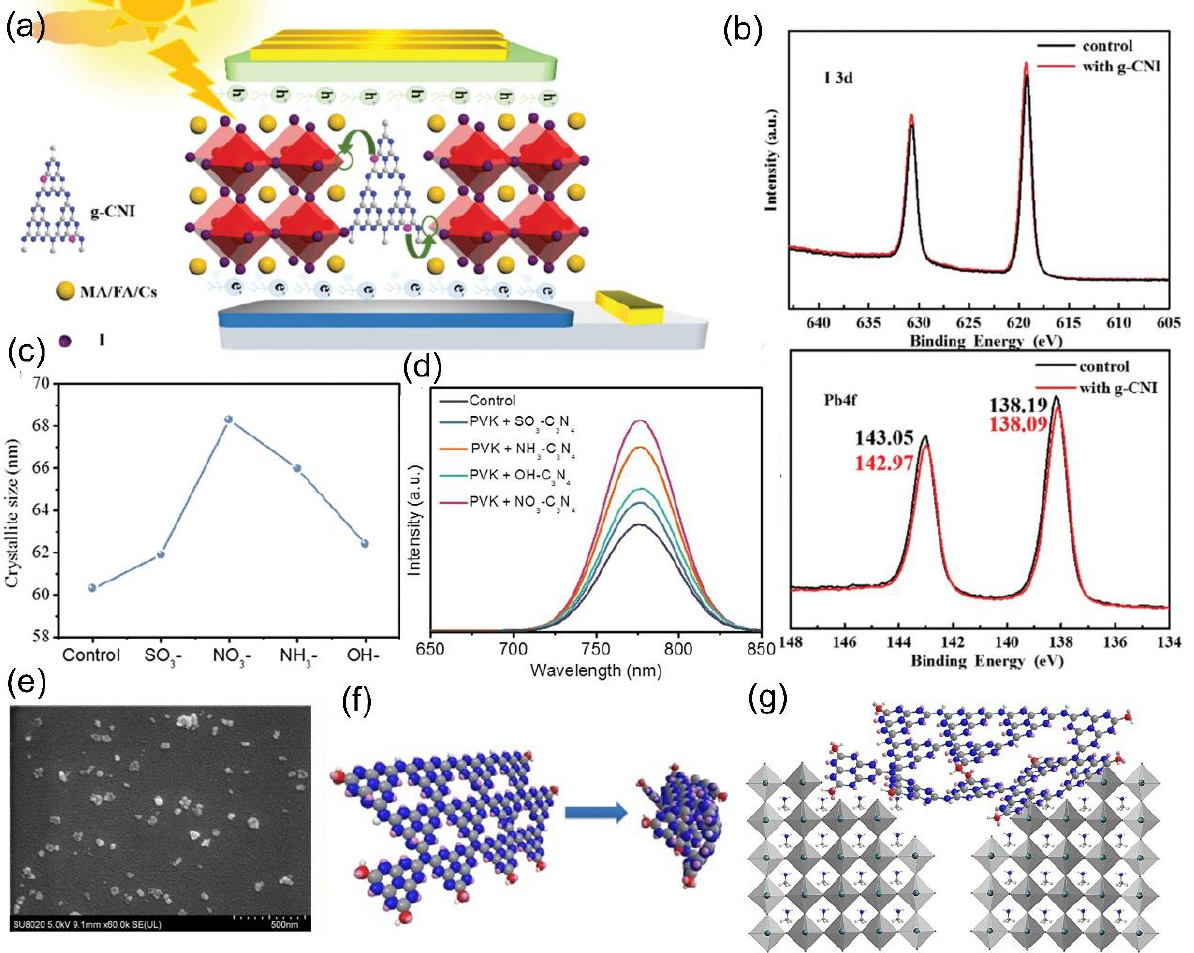
Figure 3. ( a ) Mechanism illustration of g – CNI modified PSCs. ( b ) XPS spectra of Pb 4f and I 3d in perovskite (reproduced with permission [76]; copyright 2019, Royal Society of Chemistry). ( c ) Average crystallite size. ( d ) PL spectra of perovskite films with different functionalized g – C 3 N 4 (reproduced with permission [41]; copyright 2019, John Wiley and Sons). ( e ) FESEM images of U – g – C 3 N 4 nanoparticles. ( f ) Scheme of g – C 3 N 4 fragments coils into U – g – C 3 N 4 nanoparticles. ( g ) Scheme of the